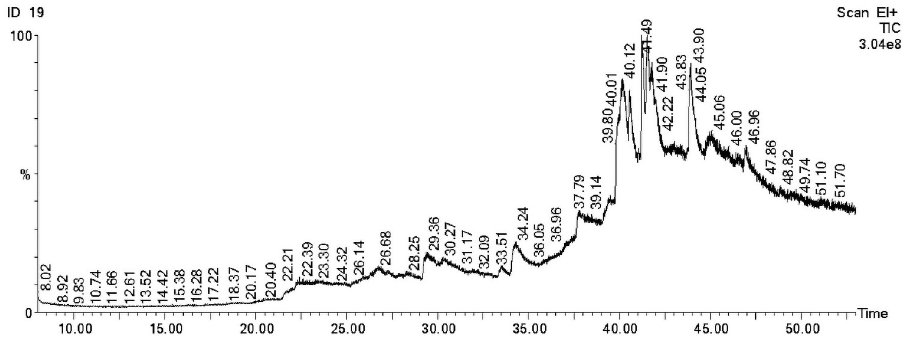
Fig 7. GC-MS based chemical profiling of ethyl acetate extract from IBSD-19 fungi strain.